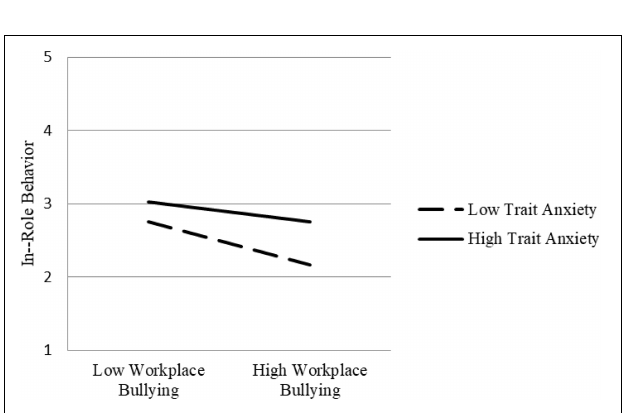
FIGURE 4 | Schematic diagram of interaction effect (in-role behavior).